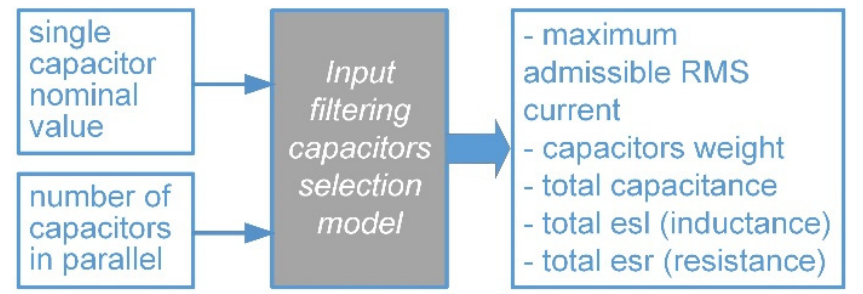
Figure 7. Formulation of the input filtering capacitors selection model.